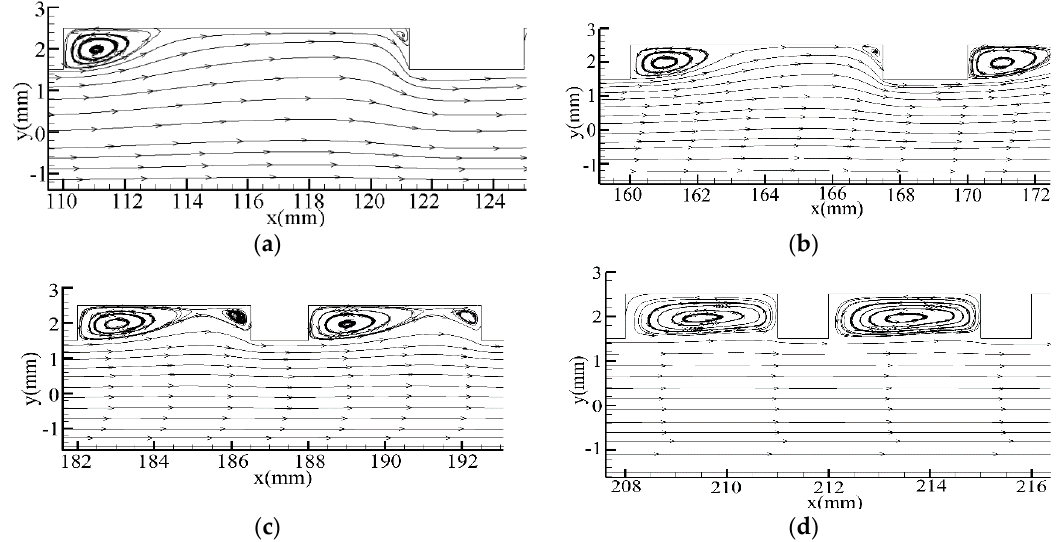
Figure 13. Streamline diagram in a narrow channel under different ( b ) ( b ) L u = 10 mm; ( c ) L u = 6 mm; ( d ) L u = 4 mm.